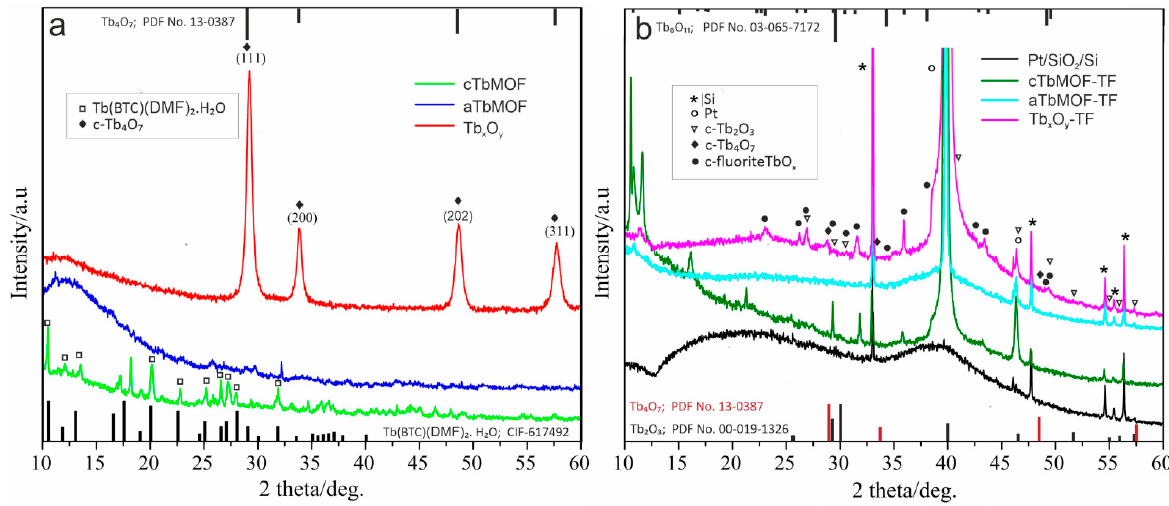
Figure 2. XRD patterns of ( a ) cTbMOFs, aTbMOF, and Tb x O y powders and ( b ) cTbMOF-TF, aTbMOF-TF, and Tb x O y -TF thin films.